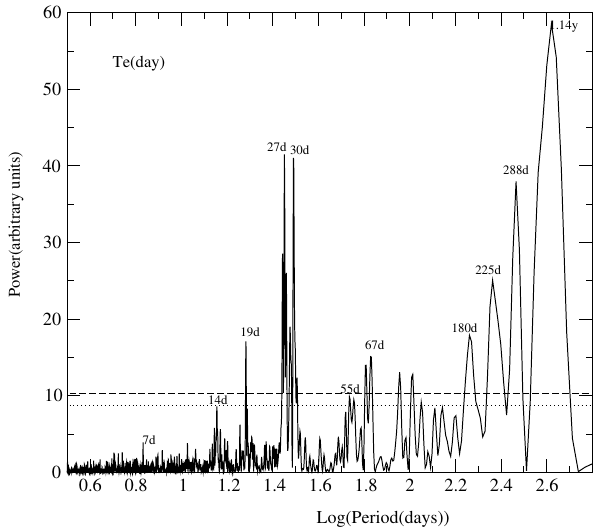
Fig. 3. Periodogram of daytime electron temperature. The numbers in the figure indicate the corresponding period in days. The dashed upper line is the upper limit of the 90% confidence level and the lower dotted line corresponds to the upper limit of 50% confidence level of the white noise